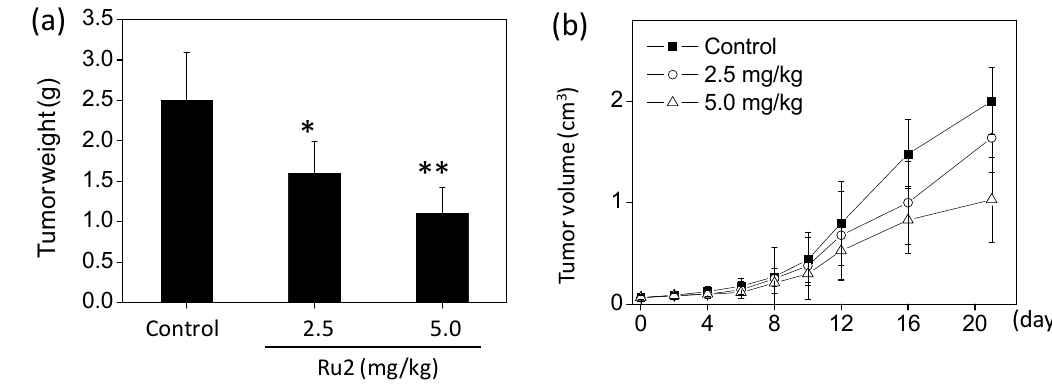
Figure 9. In vivo antitumor efficacy and action mechanisms of Ru2 . Inhibition of HepG2 xenograft tumor weight ( a ) and tumor volume ( b ) by Ru2 . BALB/c nude mice bearing HepG2 xenograft tumors were treated with the complex (2.5 and 5.0 mg/kg every other day) for 20 days. * p < 0.05 and ** p < 0.01 compared with the control.